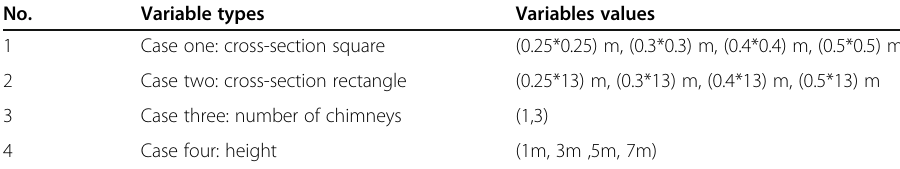
Table 3 Design variables include the engineering parameters that control the shape of the solar